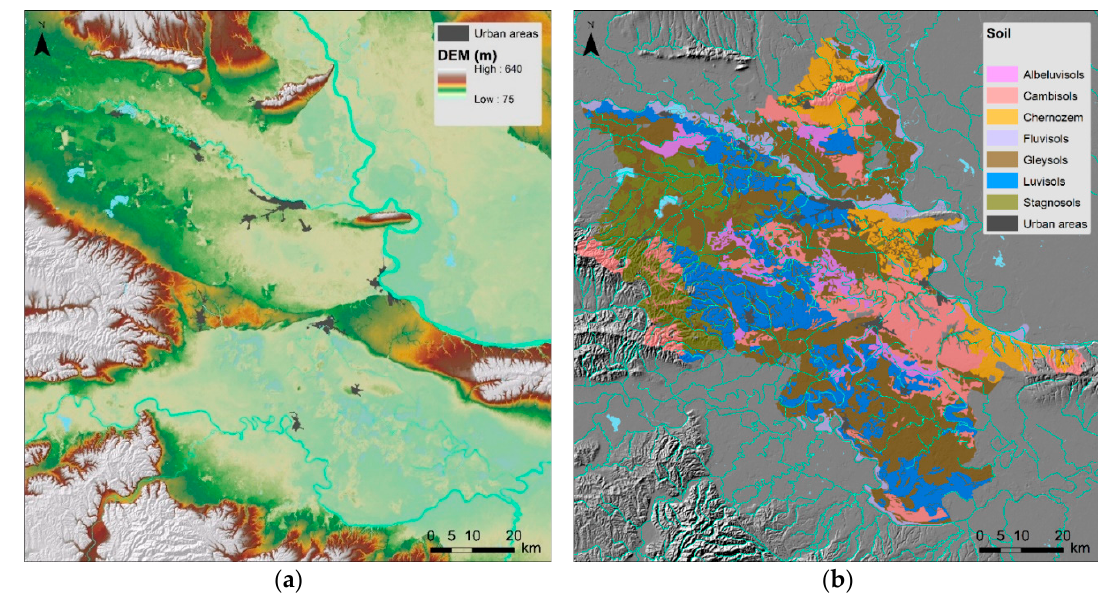
Figure 1. ( a ) topography of the study area, as depicted by the Alos AW3D30 (version 2.1) digital surface model, and the main rivers; ( b ) Soil map (according to General Soil Map of Croatia) and drainage network draped on the digital shaded relief.